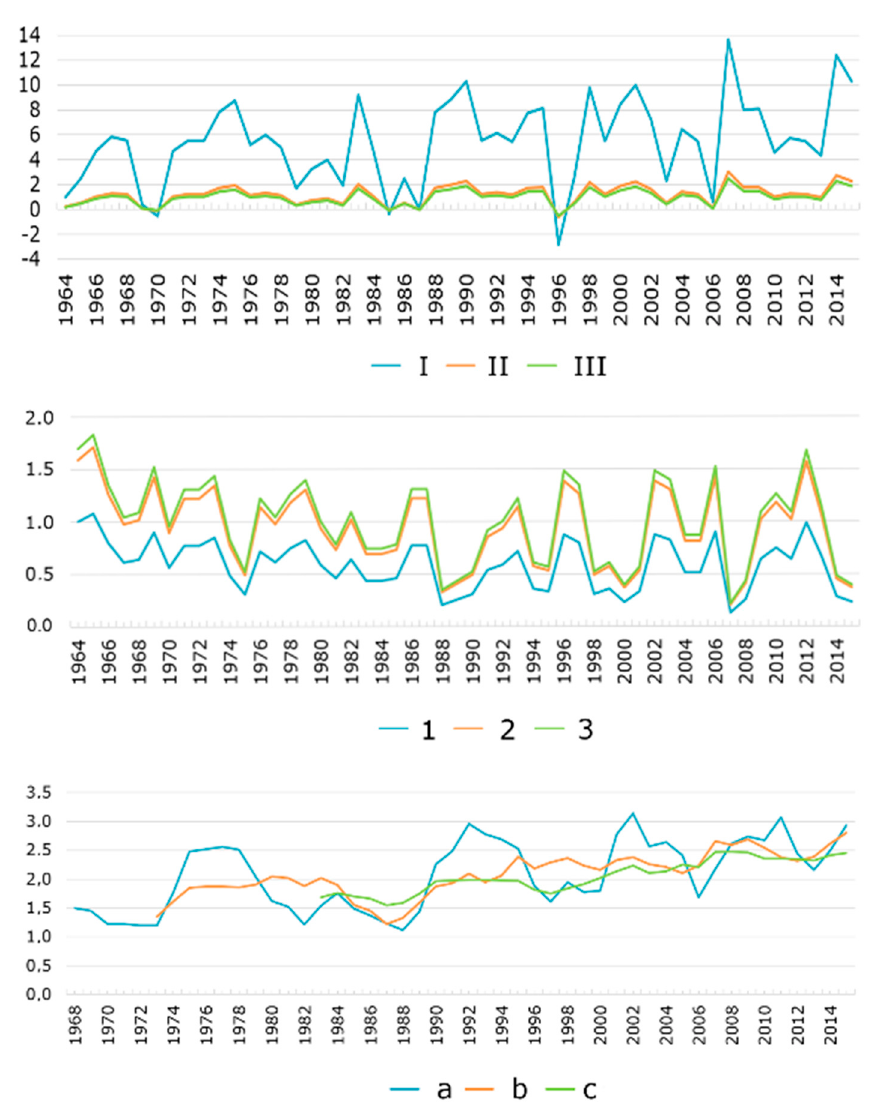
Figure 3. Fixed-base index values for average atmospheric air temperatures in winter seasons in Katowice (baseline values: I—1964; II—1964–1990; III—1964–2015) and for maximum ice cover thickness in the Kozłowa G ó ra reservoir (baseline values: 1—1964; 2—1964–1990; 3—1964–2015) and moving averages for average atmospheric air temperatures in winter seasons in Katowice (periods: a—5 years, b—10 years, c—20 years) in the years from 1964 to 2015. The increase in air temperatures translated into ice phenology in the reservoir studied.